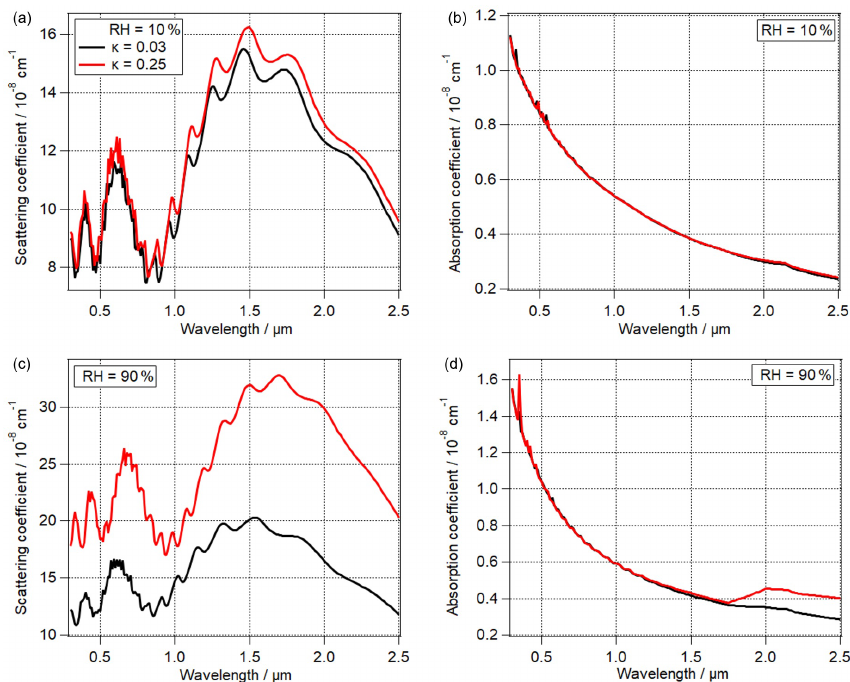
Figure 4. The effect of PBAP hygroscopicity ( κ ) on (a) scattering coefficient, (b) absorption coefficient of total particles at RH = 10% ( S opt7 , S opt8 ), (c) scattering coefficient, and (d) absorption coefficient of total particles at RH = 90% ( S opt9 , S opt10 ). The black lines indicate κ = 0.03 and the red lines indicate κ = 0.25 for all